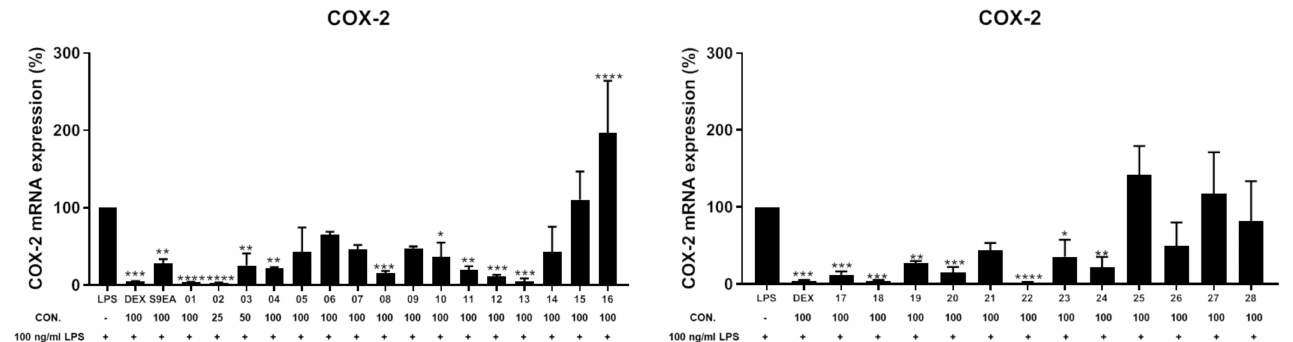
Figure 13. The inhibitory effect of 1 – 28 on LPS-induced COX-2 mRNA expression in dendritic cells by the RT-PCR analysis. The values are mean SEM ( n = 3); * p < 0.05, ** p < 0.01, *** p < 0.001, **** p < 0.0001 compared with the LPS alone stimulated group. The relative intensity of the LPS alone stimulated group was taken as 100%. The bar chart shows the results of the EtOAc extract of soft coral Cespitularia sp. (S9-EA) at 100 µ g/mL and compounds 1 – 28 (25–100 µ M) toward COX-2 mRNA